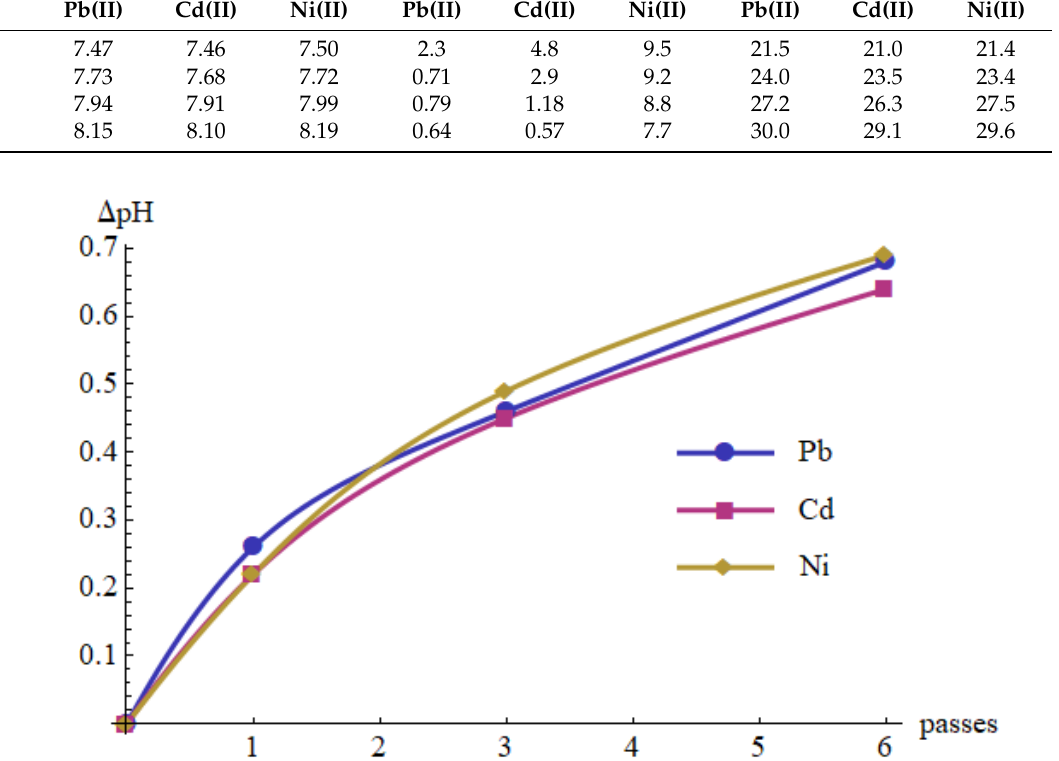
Figure 4. Changes in the pH of the Pb(II), Cd(II) and Ni(II) aqueous solutions vs. number of passes through the cold plasma reactor.